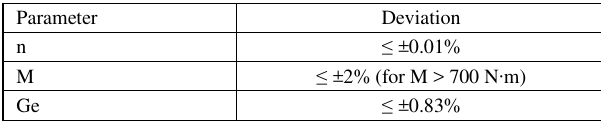
Table 2. Measuring deviation values of the instruments when recording data from the CAN bus Parameter